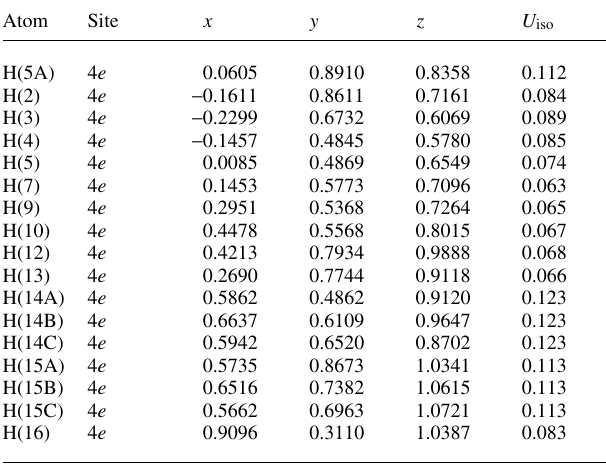
Table 2. Atomic coordinates and displacement parameters (in Å 2 )